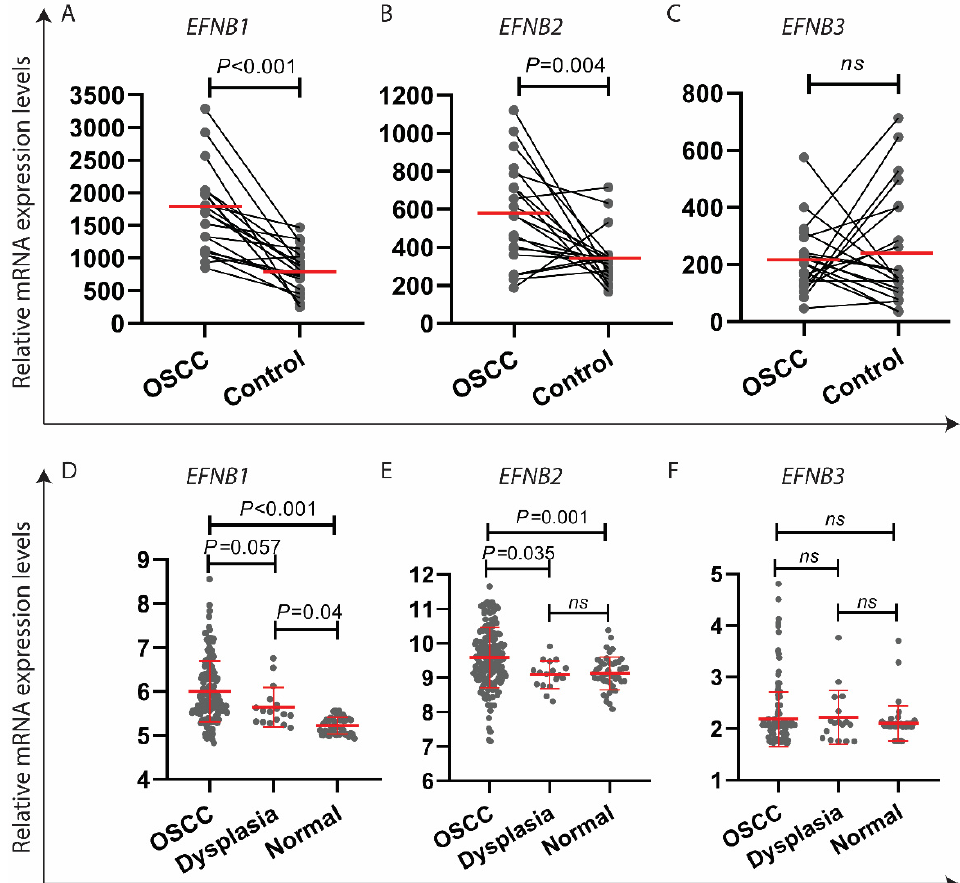
Figure 2. EFNB1 and EFNB2 mRNA levels were up-regulated in OSCC. EFNB1 and EFNB2 mRNA levels were found to be significantly upregulated in OSCC specimens as compared to normal controls ( A , B , D , E ) in two independent OSCC microarray datasets (( A ) GSE13601 [30]; consisting of tongue OSCC and pair-wised normal tongue epithelium, n = 20, and ( B ) GSE30784 [31], consisting of 167 OSCC, 45 normal control and 17 oral dysplasia). However, EFNB3 mRNA levels were found to be similar between OSCC and controls ( C , F ). Paired Student’s t-tests were performed in ( A – C ), while one-way ANOVA with Tukey’s multiple corrections was used in ( D – F ). Horizontal bars represent mean values. Error bars in D-F represent standard deviations.